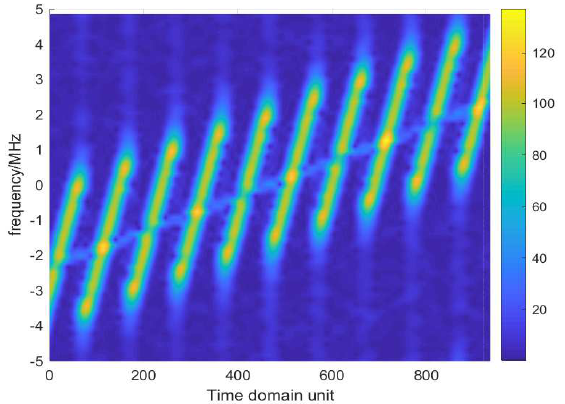
Figure 7. Time-frequency distribution of the mixed